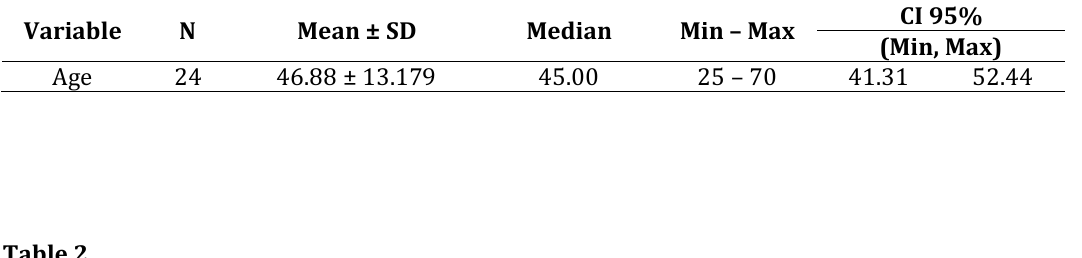
Distribution of respondent characteristics based on gender, family support, and self-efficacy at the Kidney and Sustainable Hypertension Clinic October 2022 (n=24)